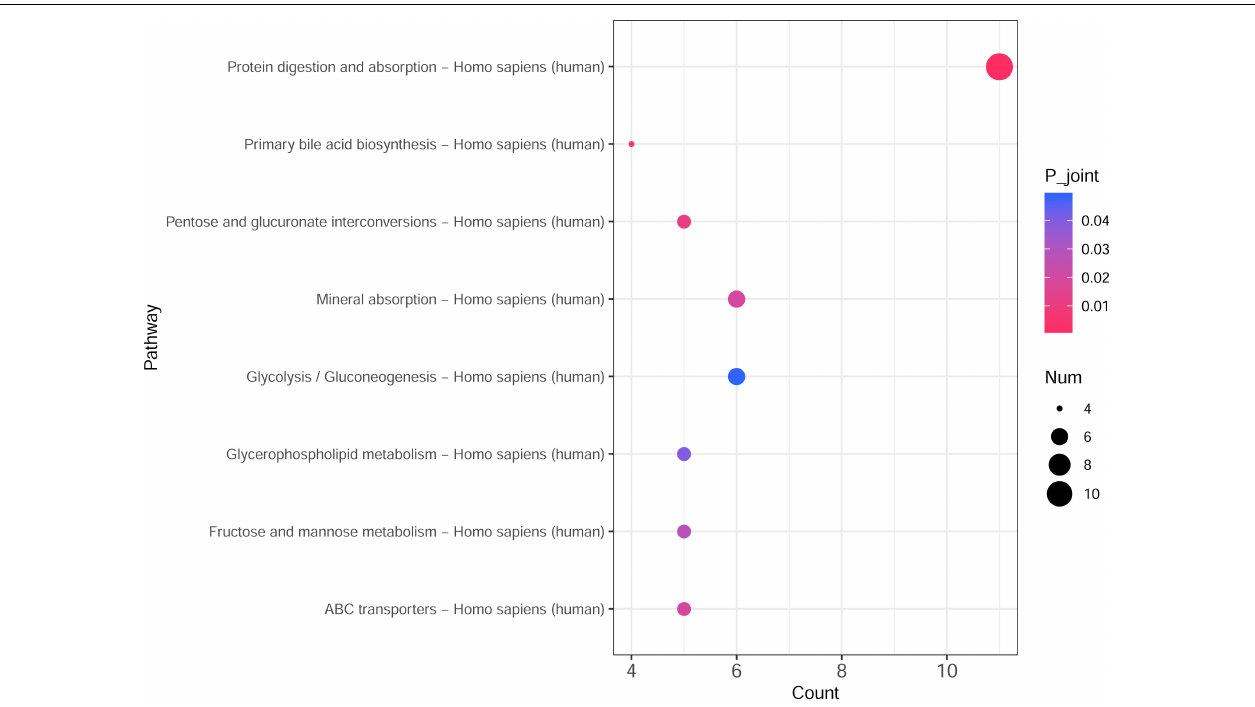
FIGURE 6 | Integrated transcriptomic and metabolomic analysis results to identify crucial KEGG pathways related to ovarian cancer. The horizontal axis is the pathway categories, and the vertical axis is the count number of differential genes and metabolites. A p < 0.05 represents a significant difference, and the dots with the color changing from pink to red represents a smaller p